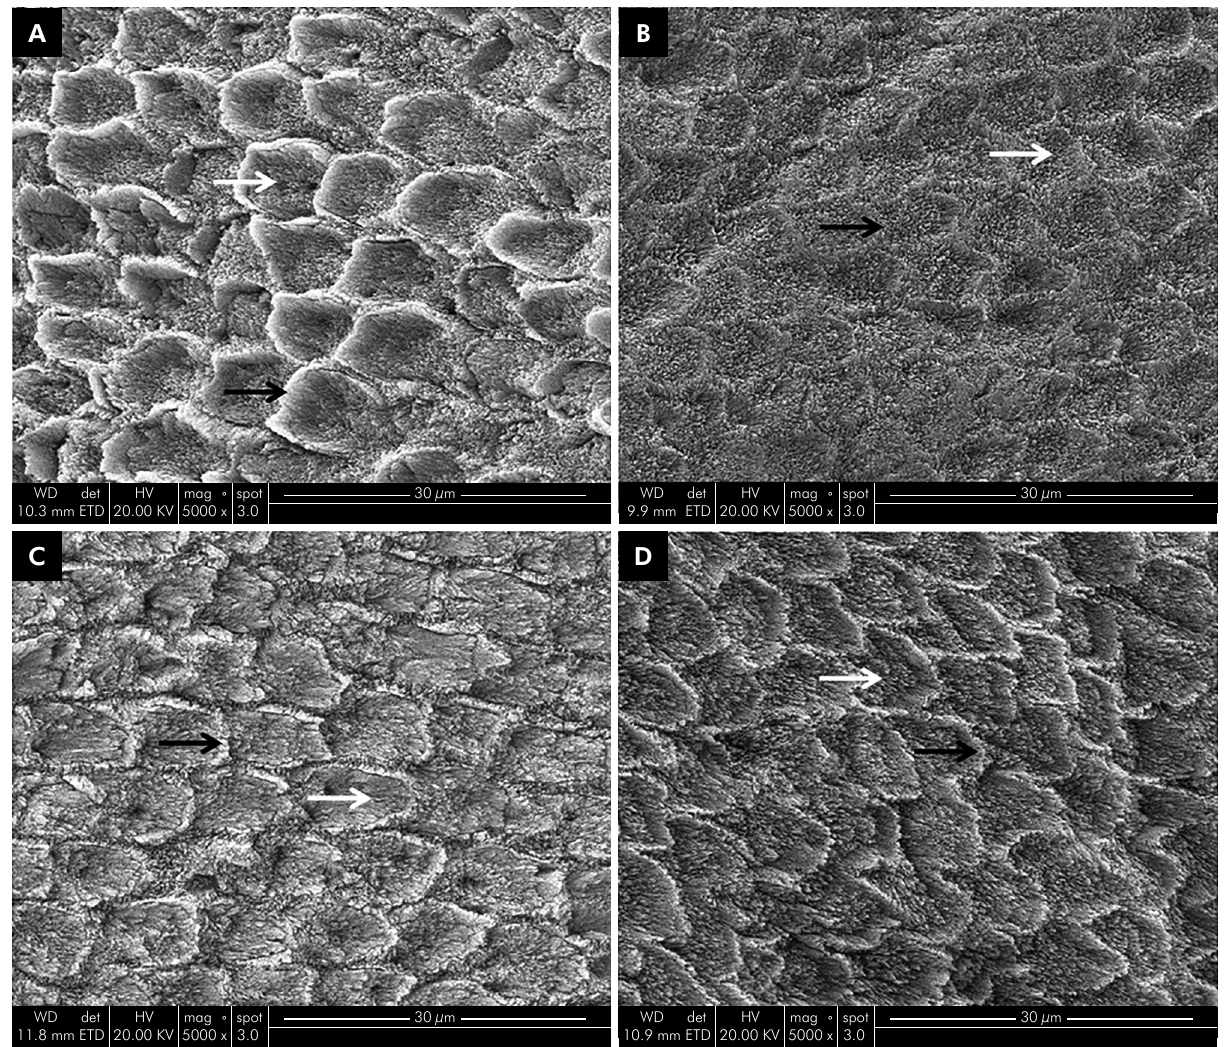
Figure 2. SEM micrographs (5,000x) of the enamel surfaces etched with 37% phosphoric acid (A), GSE5 (B), GSE10 (C), and GSE20 (D). The predominant dissolution of the enamel prism core (white arrows) with simultaneous conservation of the marginal area (black arrows) is shown for the four acid solutions. However, this etching pattern is shallower for GSE5 and more evident for 37% phosphoric